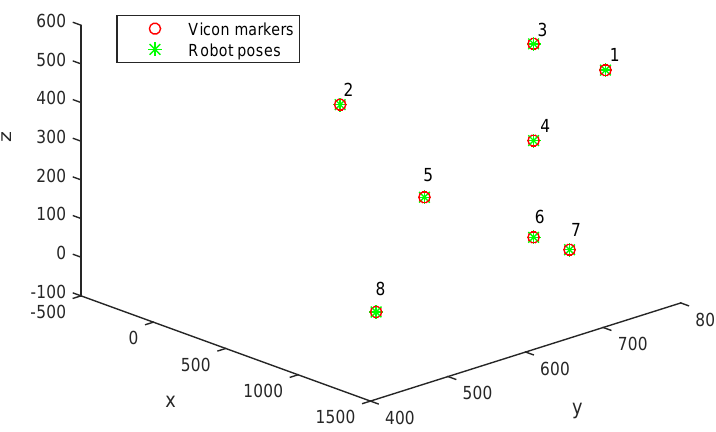
Figure 3. Eight static points after Vicon and robot frame alignment.